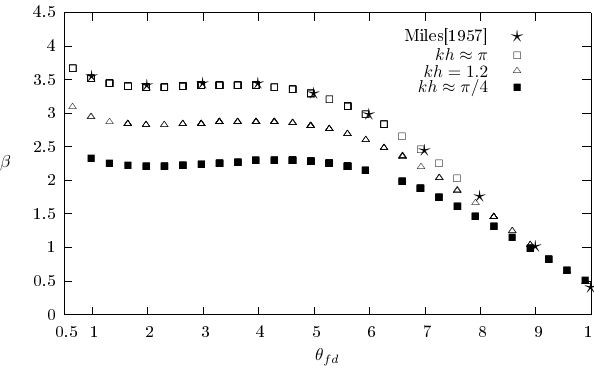
Fig. 1. The drag coefficient versus the U 10 wind velocity. As we can see, it follows a linear progression until its maximum around 30 m s − 1 , then decreases. So, a linear parametrization of C 10 is a reasonable approximation.